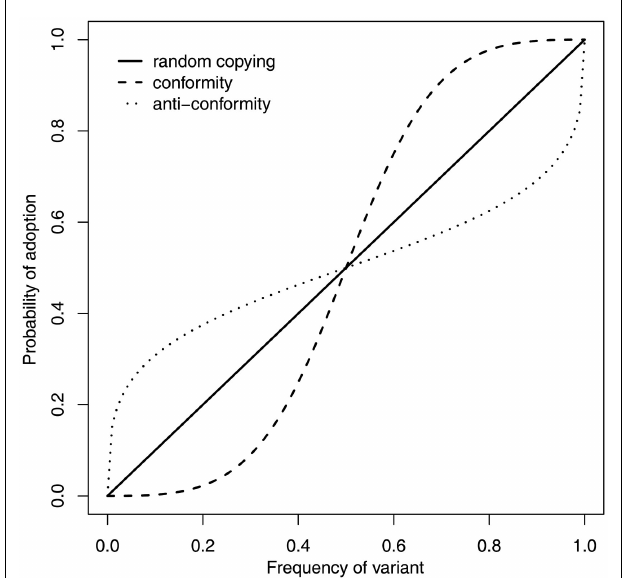
FIGURE 1 | Conformity (the dashed line) is just one of several learning rules that result in increasingly likely adoption of a trait as it increases in frequency, however, it is unique as the tendency toward the most popular trait is disproportionate given its frequency. A proportionate tendency, equivalent to random copying (solid line), results in a probability of adoption equal to trait frequency, whereas anti-conformity (dotted line) resists the most popular choice and has the opposite population consequences to conformity. Of these frequency dependent rules, only conformity leads to homogenous group